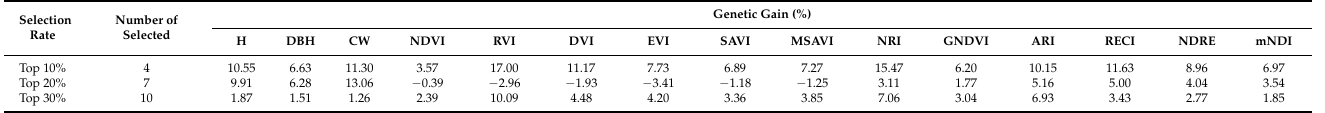
Figure 9. Selection index scatter plots of clones, where the top 10%, 10–20%, and 20–30% of the superior clones are color-coded. The horizontal coordinate is the selection index value of the tree growth traits, and the vertical coordinate is the selection index value of the vegetation index. Table 5. Expected genetic gain of superior clones, according to the inclusion proportions of 10%, 20% and 30%.